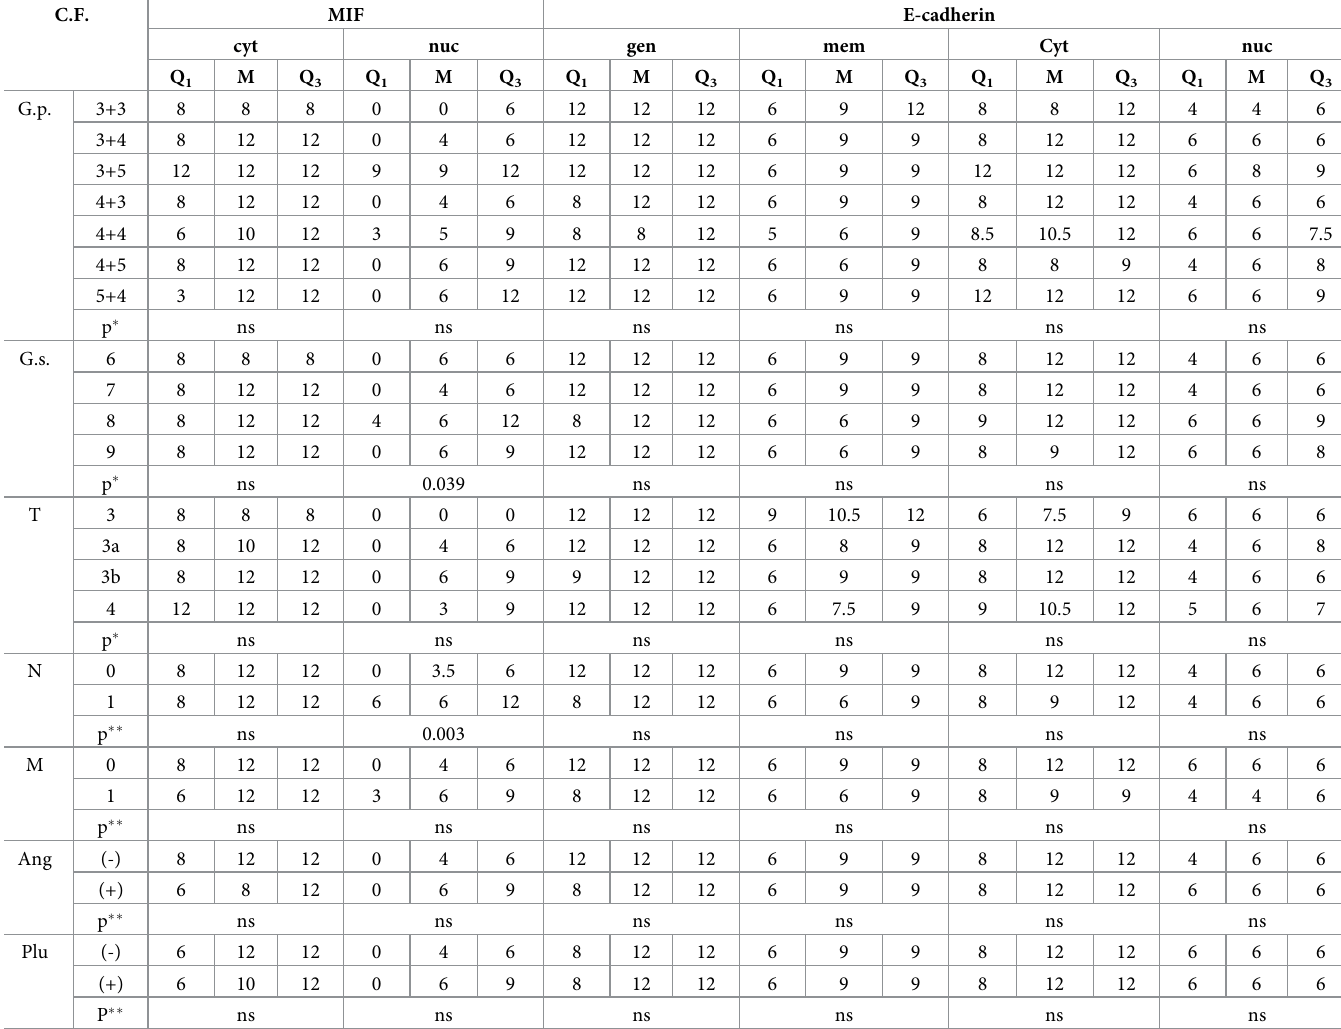
Table 4. Correlation between expression of MIF and E-cadherin and clinicopathological features of prostate cancer. C.F.